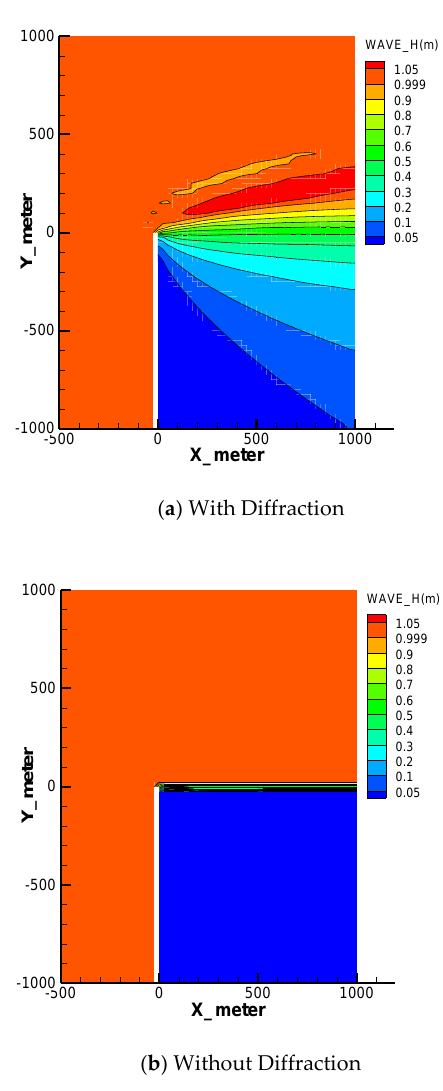
Figure 12. Contours of the significant wave height predicted by SRH-Coast with and without diffraction activated.